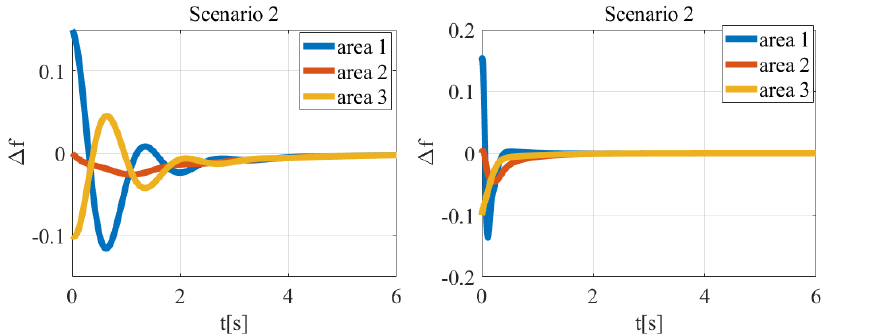
Figure 12. The time responses of ∆ f with LQR ( left figure) and fuzzy controller ( right figure) for different areas—scenario 2.